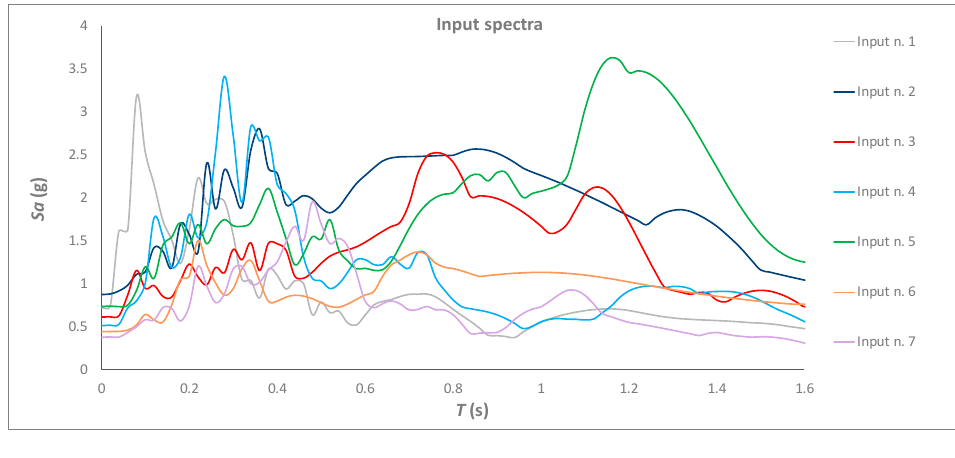
Figure 1. Selected input motions. Table 1. Input motions characteristics: Peak Ground Acceleration (PGA), Peak Ground Velocity (PGV), Peak Ground Displacement